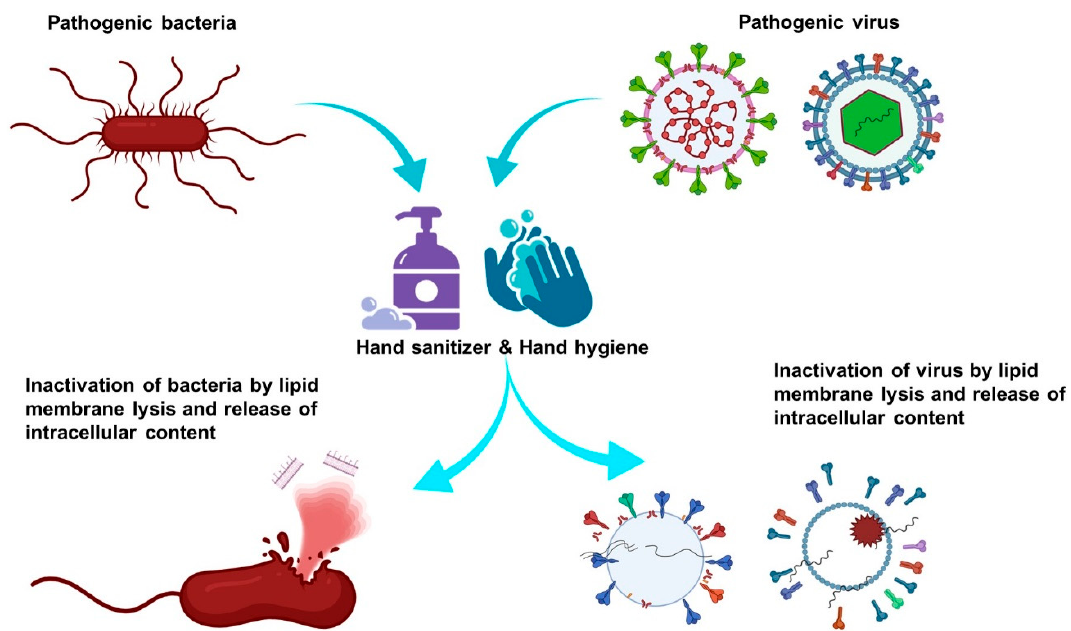
Figure 3. Illustration of alcohols antiviral mechanism. (Acknowledgement: The illustration was designed using BioRender scientific illustration program).